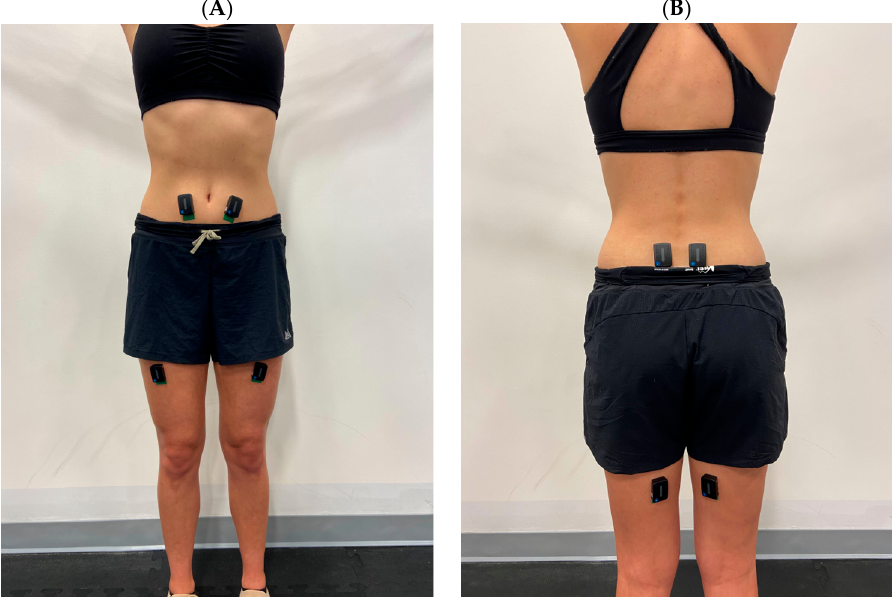
Figure 2. Locations of wearable surface electromyography sensors on the body. Sensors were placed bilaterally on the multifidus, rectus femoris, biceps femoris, and rectus abdominus. Panel ( A ) illus- trates sensors placed on muscles of the anterior side of the body. Panel ( B ) illustrates sensors placed on muscles of the posterior side of the body.